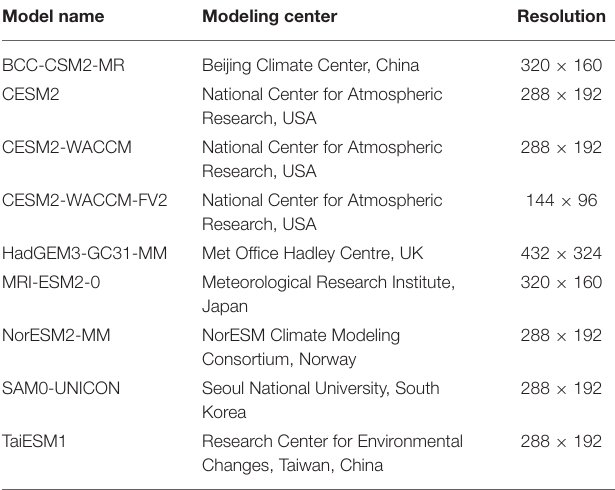
TABLE 1 | CMIP6 models used in this